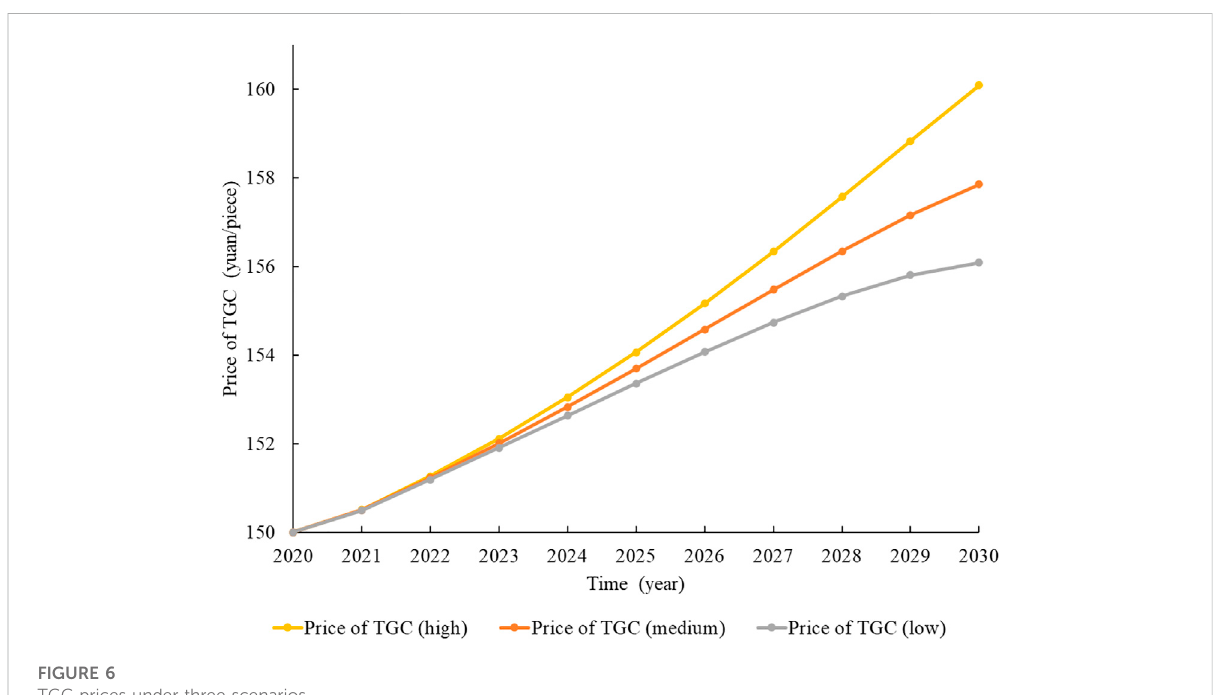
FIGURE 6 TGC prices under three